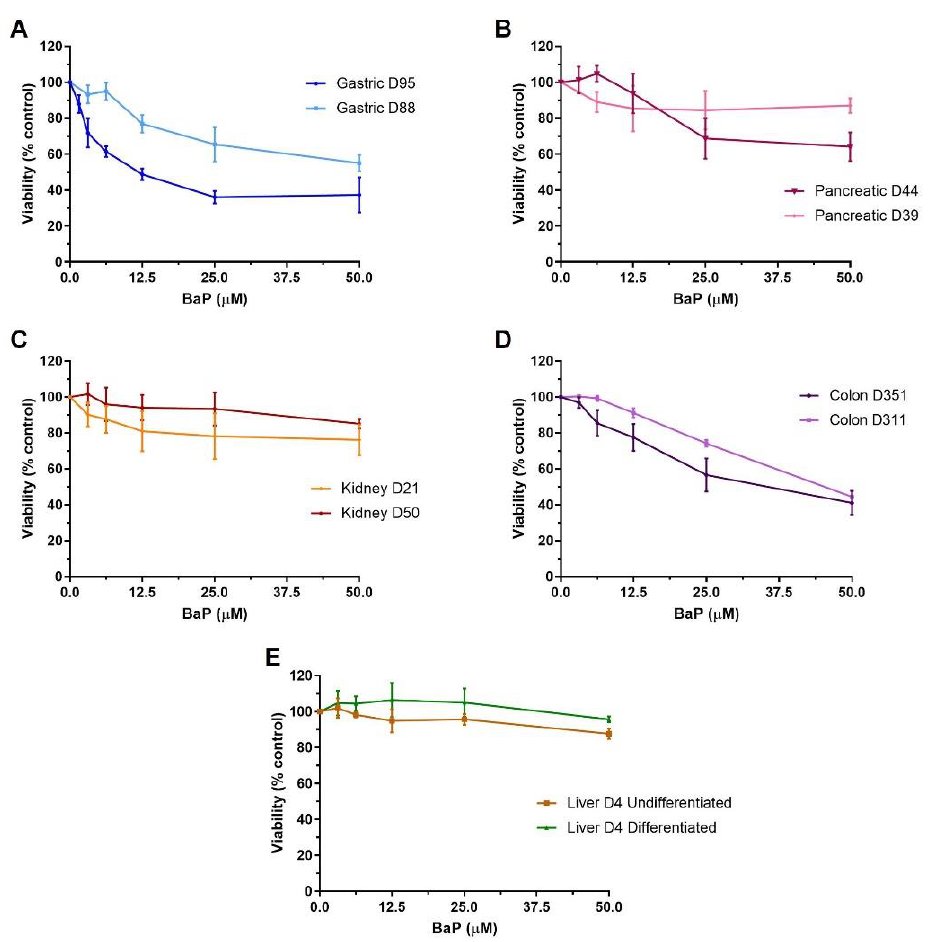
Figure 1. Cell viability in human tissue organoids after BaP treatment. Organoids from normal human stomach ( A ) D95 and D88, pancreas ( B ) D39 and D44, kidney ( C ) D50 and D21, colon ( D ) D351 and D311, and liver ( E ) D4 undifferentiated and differentiated tissues were treated with various BaP concentrations (0–50 µ M) for 48 h. Vehicle controls (0.5% DMSO) were included. Cell viability (% control) was measured using the CellTiter-Glo assay. Results are shown as mean ± SEM ( n ≥ 3 ).